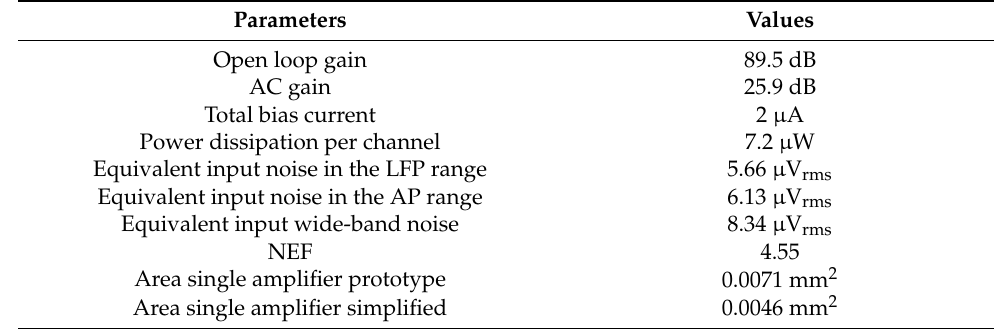
Table 3. Parameter of the amplifier based on post-layout simulations. Cutoff frequency was set at 0.2